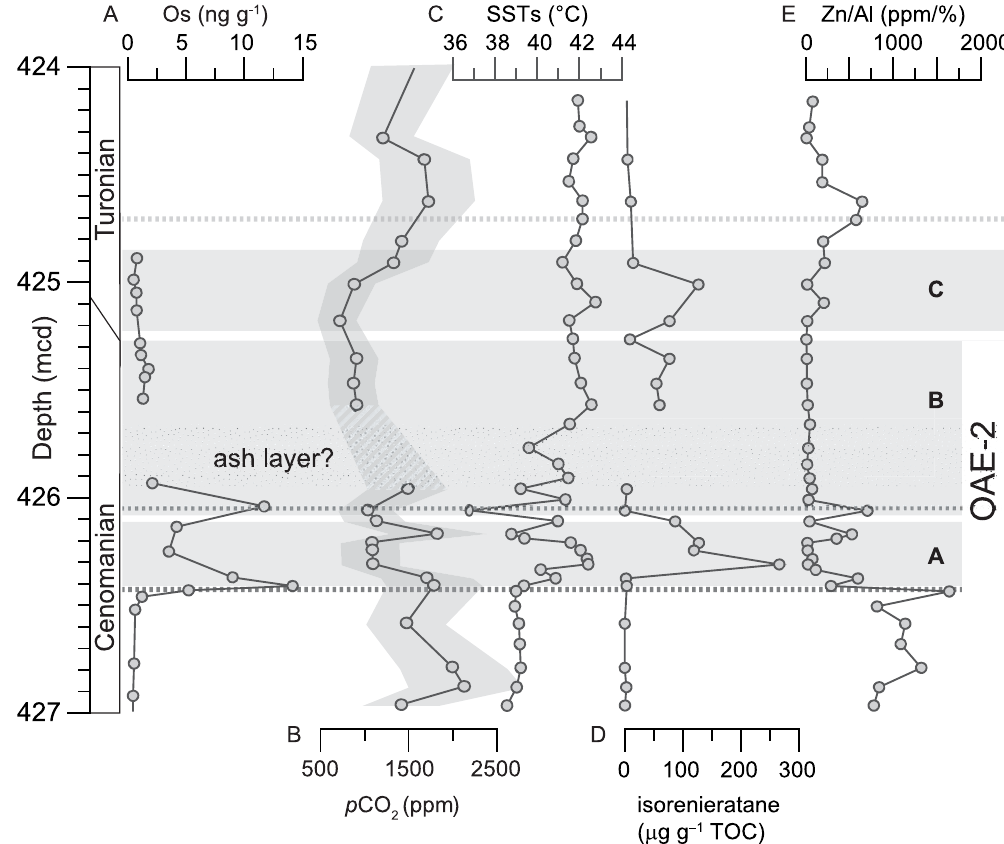
Fig. 8. (A) Osmium concentrations from Turgeon and Creaser (2008) (B) p CO 2 in ppm with the black line calculated using b = 170, the light grey area denotes the p CO 2 uncertainty calculated with b between 120 and 220 (C) Sea surface temperatures (SST) in ◦ C as reconstructed by TEX 86 (Forster et al., 2007; using the calibration of Kim et al., 2008) (D) S-bound isorenieratane concentrations in µgg − 1 TOC (van Bentum et al., 2009) (E) Zn/Al in (ppm %). Grey areas indicate the OAE-2 interval, stippled grey lines indicate possible magmatic